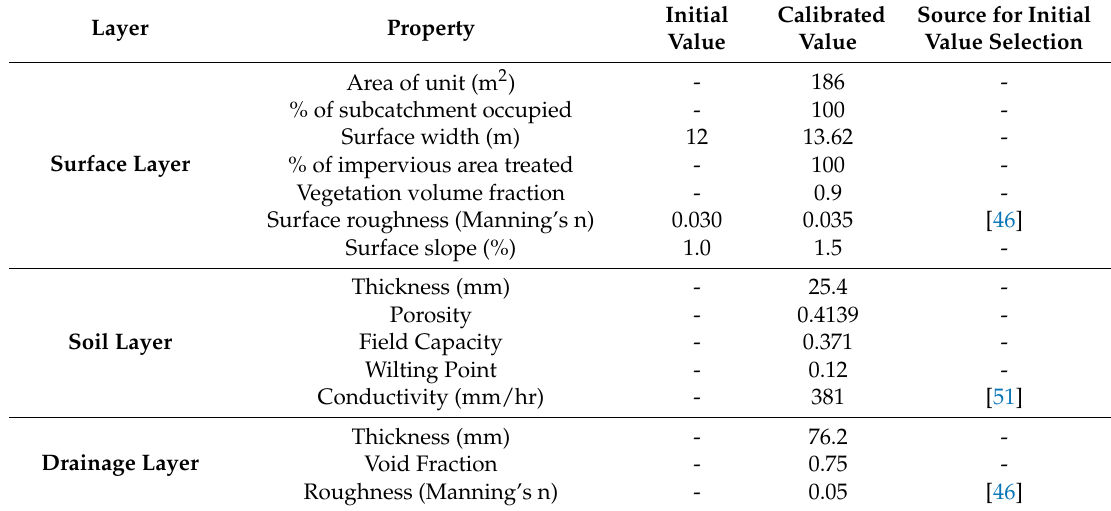
Table 3. Green roof Low Impact Development (LID) control properties defined in SWWM. Layer Property